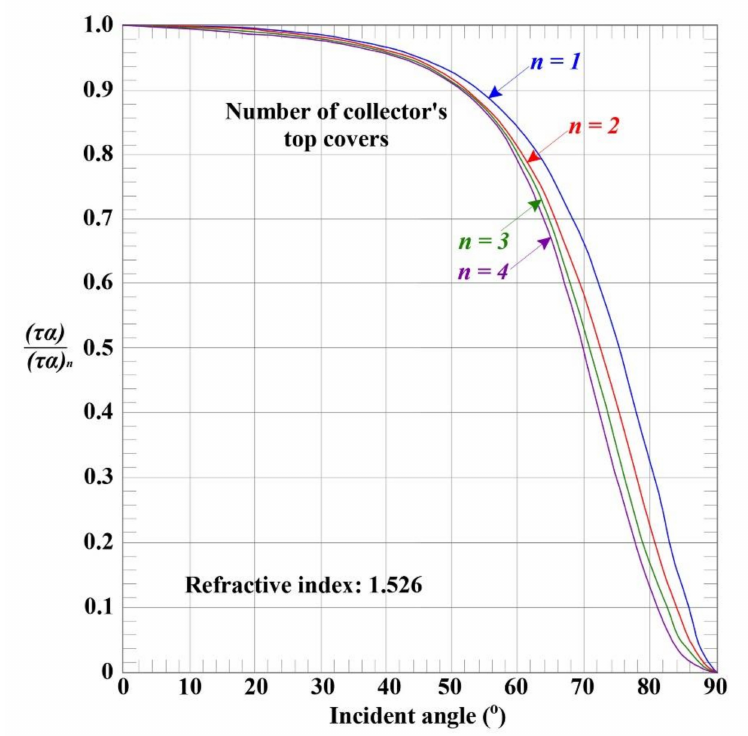
Figure 15. Fluctuation of the transmittance–absorbance product of solar collectors with a di ff erent number of top covers, versus the solar radiation incident